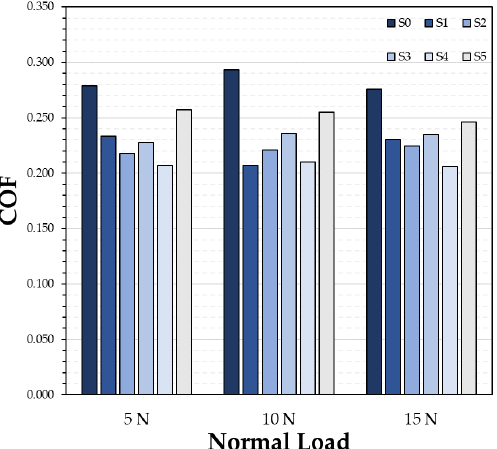
Figure 13. The change in frictional response for the bare and Zr-coated Al6061 plates as loads 5, 10, and 15 N.